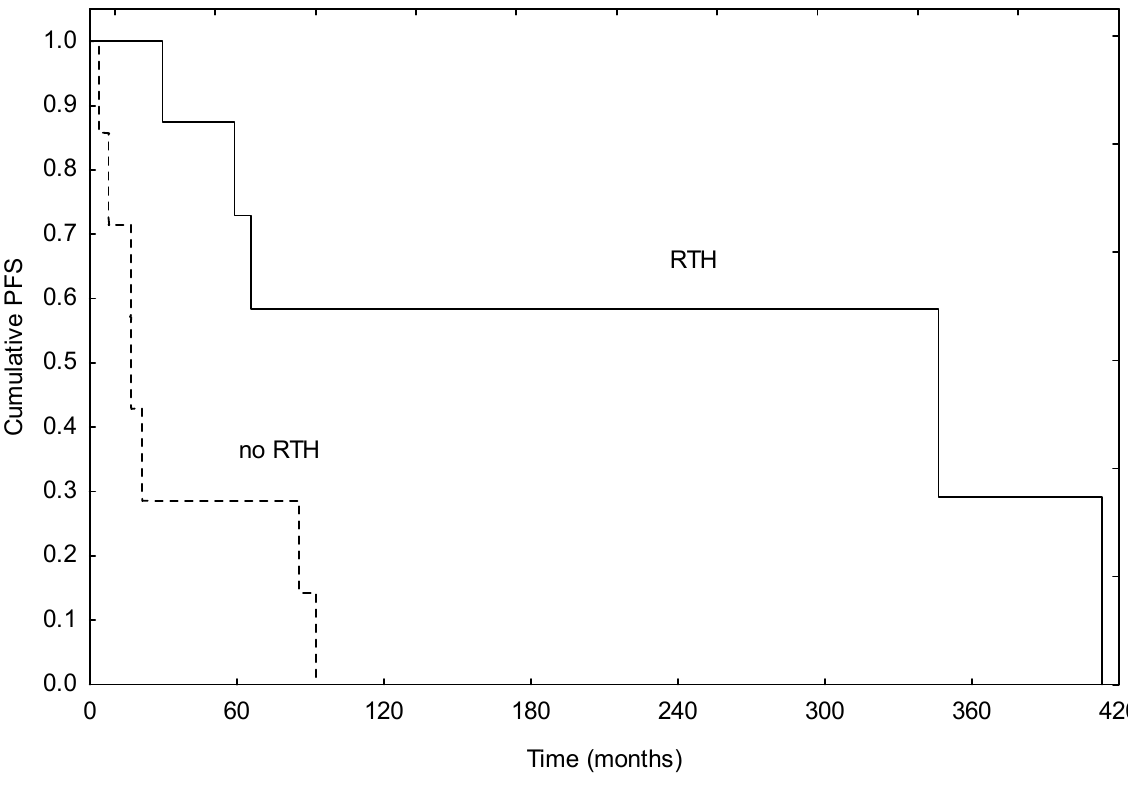
Figure 4. Progression-free survival (PFS) based on the use of radiotherapy (RTH) in the primary treatment in children under the age of 3 years old.